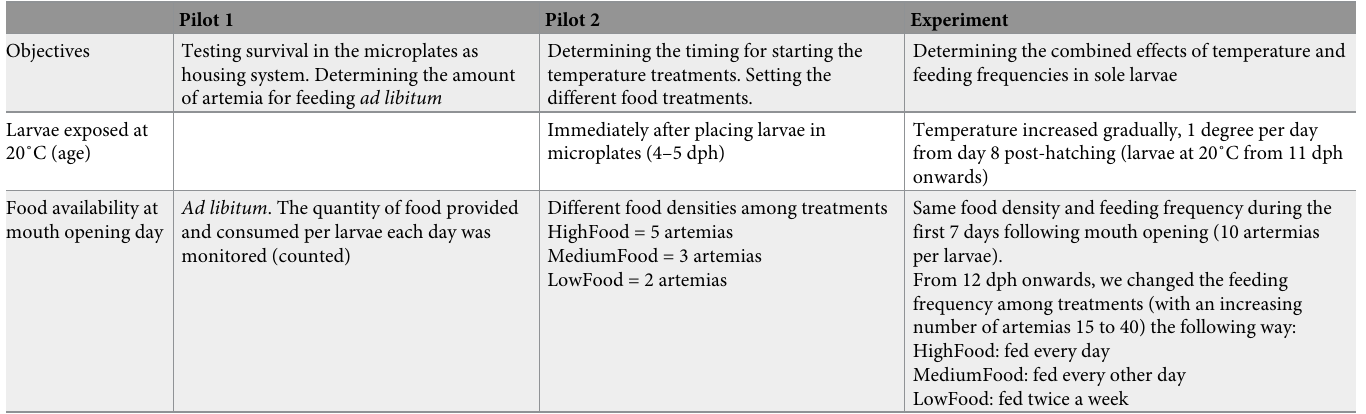
Table 1. Main differences between the pilots and the experiment conducted.